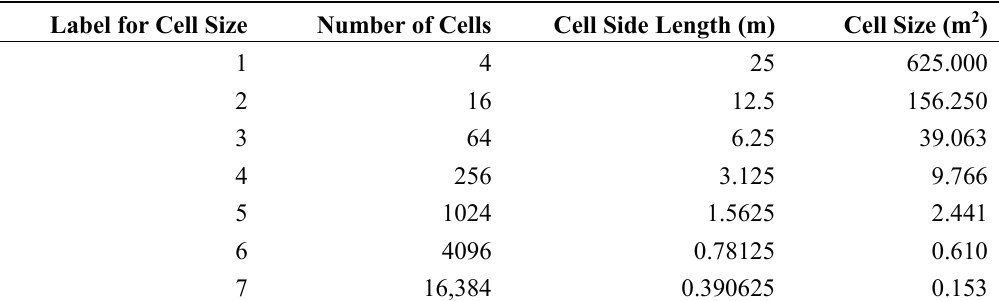
Table 2. Summary of raster cell sizes at each